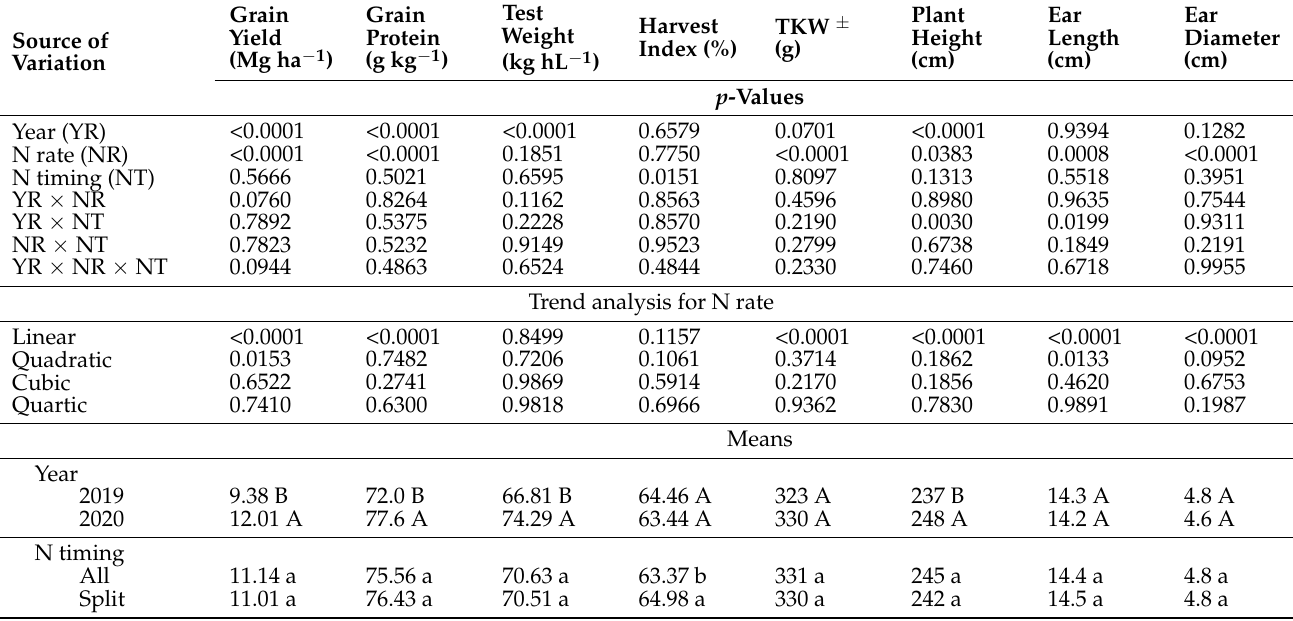
Table 3. ANOVA table showing level of significance for year (YR), N fertilizer application rate (NR), N fertilizer application time (NT) and their interactions, trend analysis and means for year and N application time on maize grain yield and yield components at Swan Lake Research Farm, near Morris, MN in 2019 and